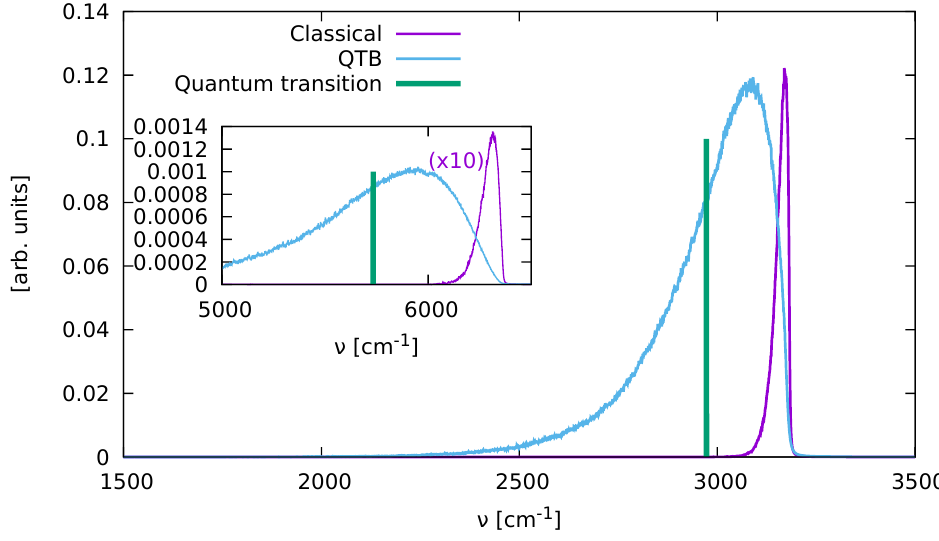
Figure 4. C vv ( ω ) spectra for the ‘mildly’ anharmonic Morse potential, for the classical MD simulation (magenta), the QTB (blue) and the first quantum transition between the ground state and first excited state (green). The inset shows show the overtones (the classical spectrum is multiplied by a factor of